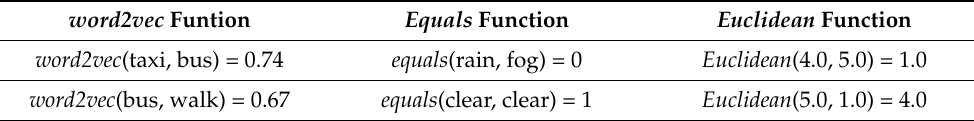
Table 2. Example of distance functions for